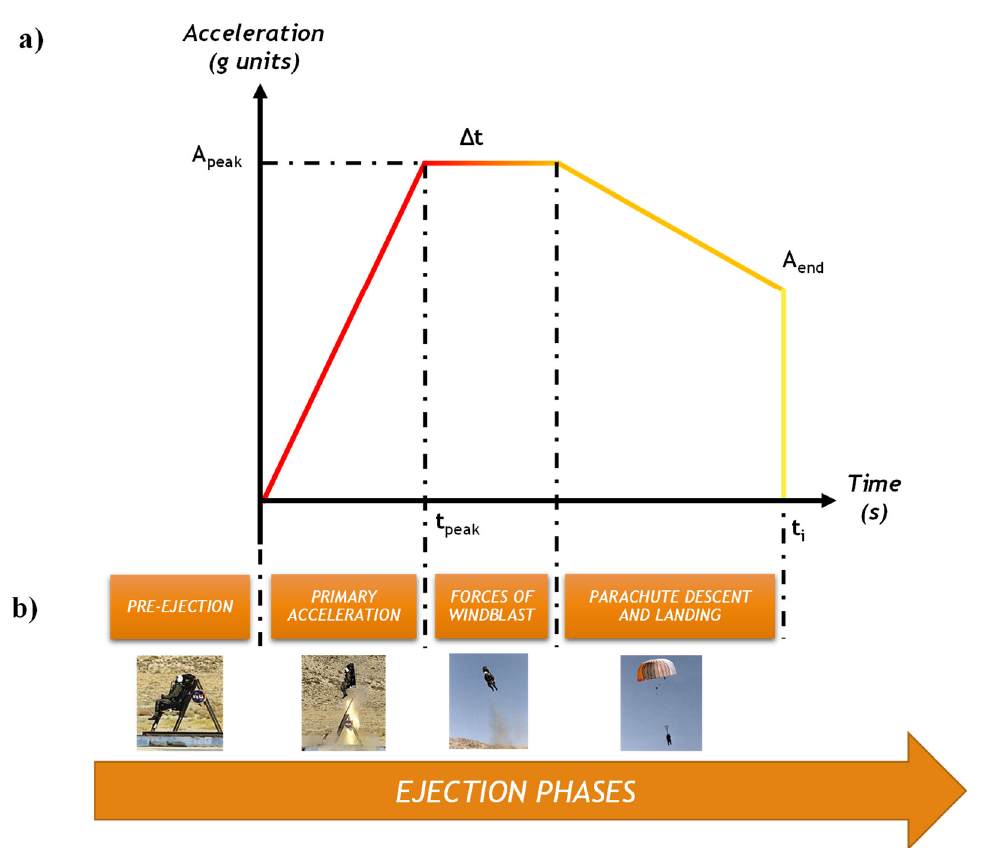
Figure 2. Acceleration shape ( a ) ejection phases and ( b ) according to military standards.